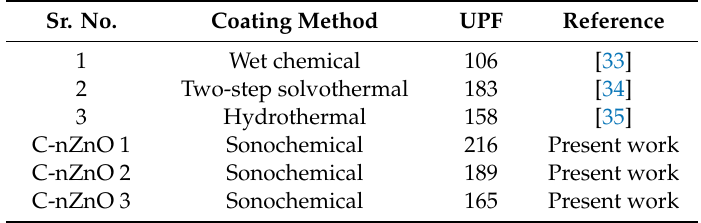
Table 2. A comparative analysis of various ZnO coated cotton composites for UPF. Sr.